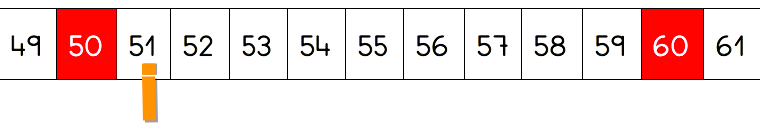
Figure 6. Detail of number